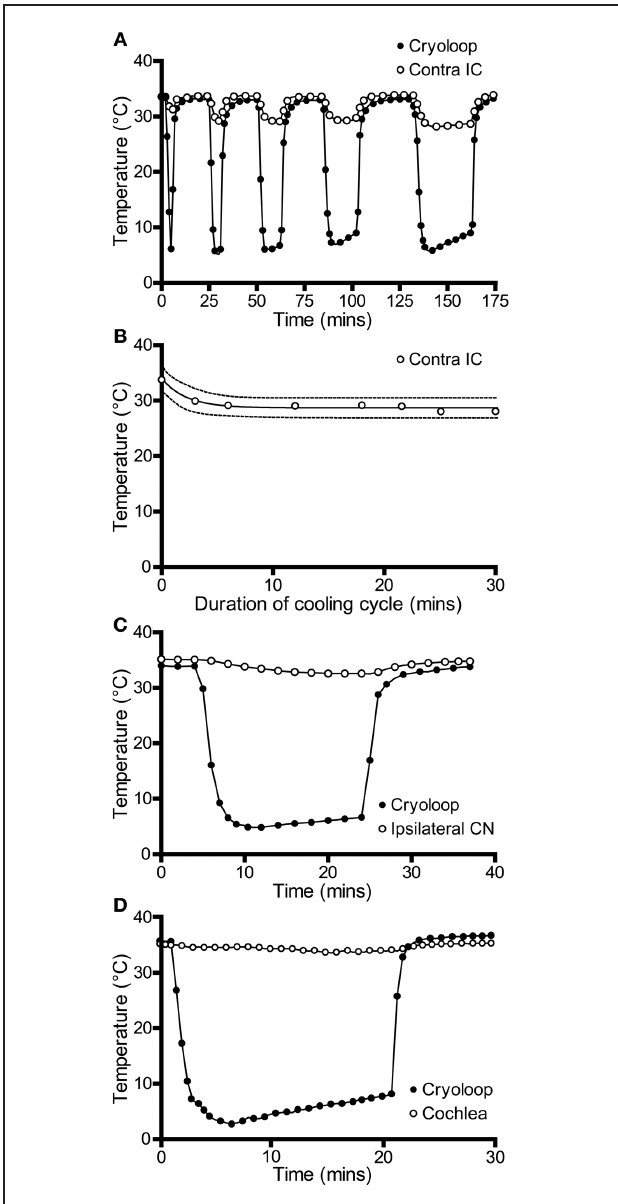
FIGURE 4 | (A) Near coronal section through the IC following an experiment. Aspiration of the cortex overlying the left IC and placement of the cryoloop did not produce any noticeable trauma to the tissue. Blood at the midline (black arrowhead) and bilaterally at the ventro-lateral edges of the tectum (red arrowheads) resulted from aspiration of the cortex. Scale bar = 1mm. (B) Neurons near the dorsal surface of the IC contacted by the cryoloop show no sign of damage. (C) Neurons within the cooled IC have normal morphology and no signs of ischemia are present. Scale bar in (B) and (C) = 50 μ